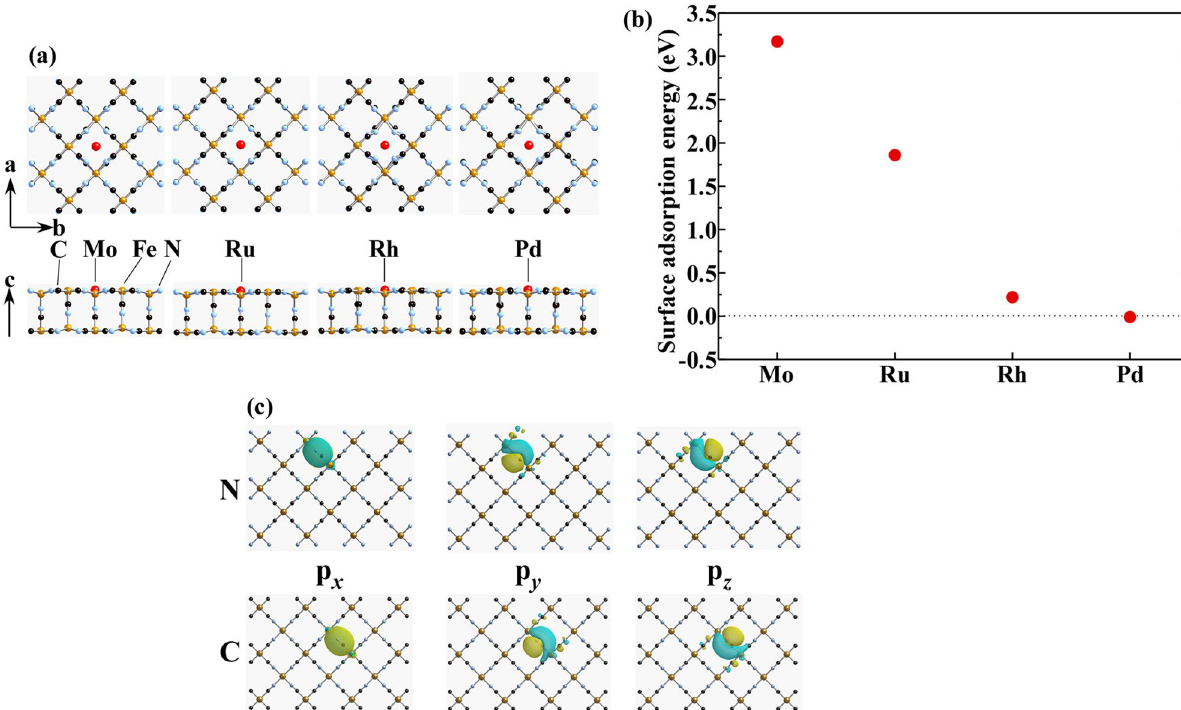
Figure 3. ( a ) Surface adsorption energy of PGMs/Mo bare ions on the (100) surface of PB, ( b ) the optimized surface structure of PGMs/Mo ions on the PB (100) surface, and ( c ) the Wannier function of the C2p and N2p atomic orbitals on the PB (100) surface (isosurface = 0.02).